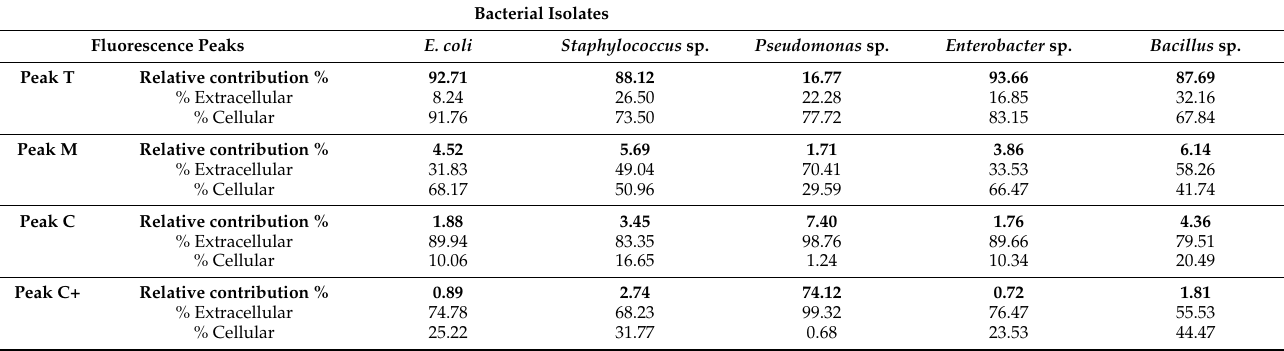
Table 3. Relative contribution (%) of peaks T, C, C+ and M to fluorescence intensities (determined from the summative cell density normalised fluorescence intensities of these peaks) produced by environmental bacterial isolates, cultured for 24 h at 30 ◦ C. The percentage fluorescence intensities for each fluorescence peak attributed to extracellular material (supernatant fraction) and cellular material (both the resuspended and lysed cells) for all isolates is also shown. Bacterial Isolates Fluorescence Peaks E. coli Staphylococcus sp. Pseudomonas sp. Enterobacter sp. Bacillus